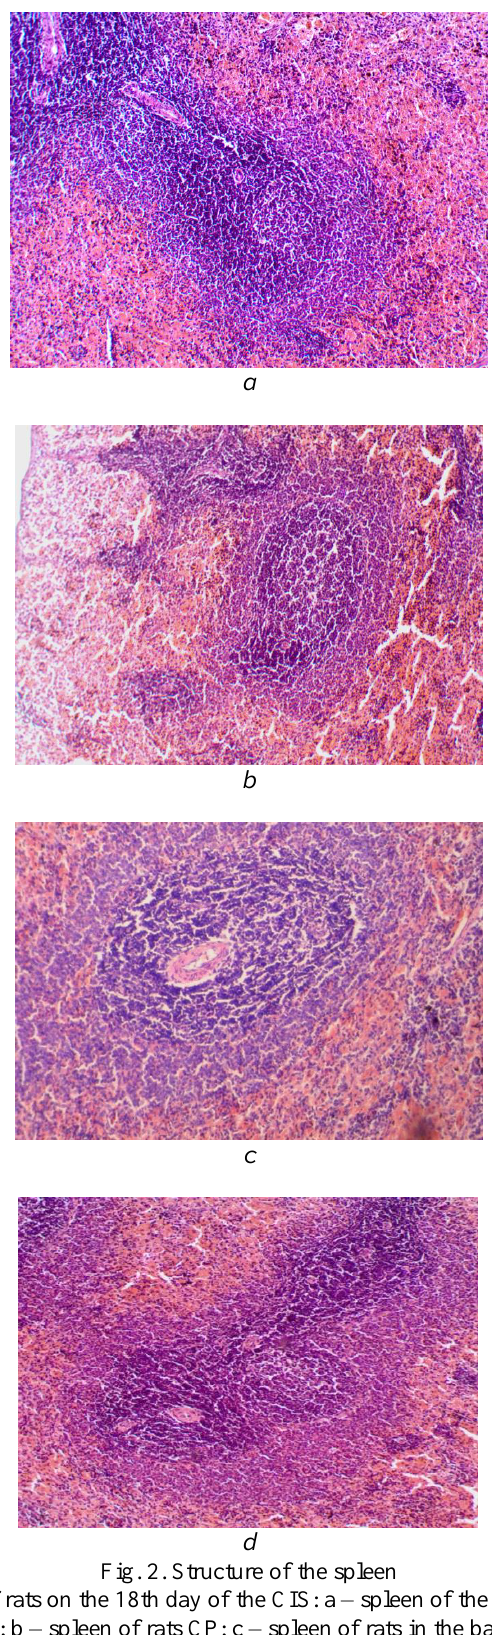
Fig. 2. Structure of the spleen of rats on the 18th day of the CIS: a – spleen of the rat IC; b – spleen of rats CP; c – spleen of rats in the back- ground of TEPL in a dose of 100 ml/kg; g - a spleen against the background of the action of CD "Immuno- Ton" in a dose of 3